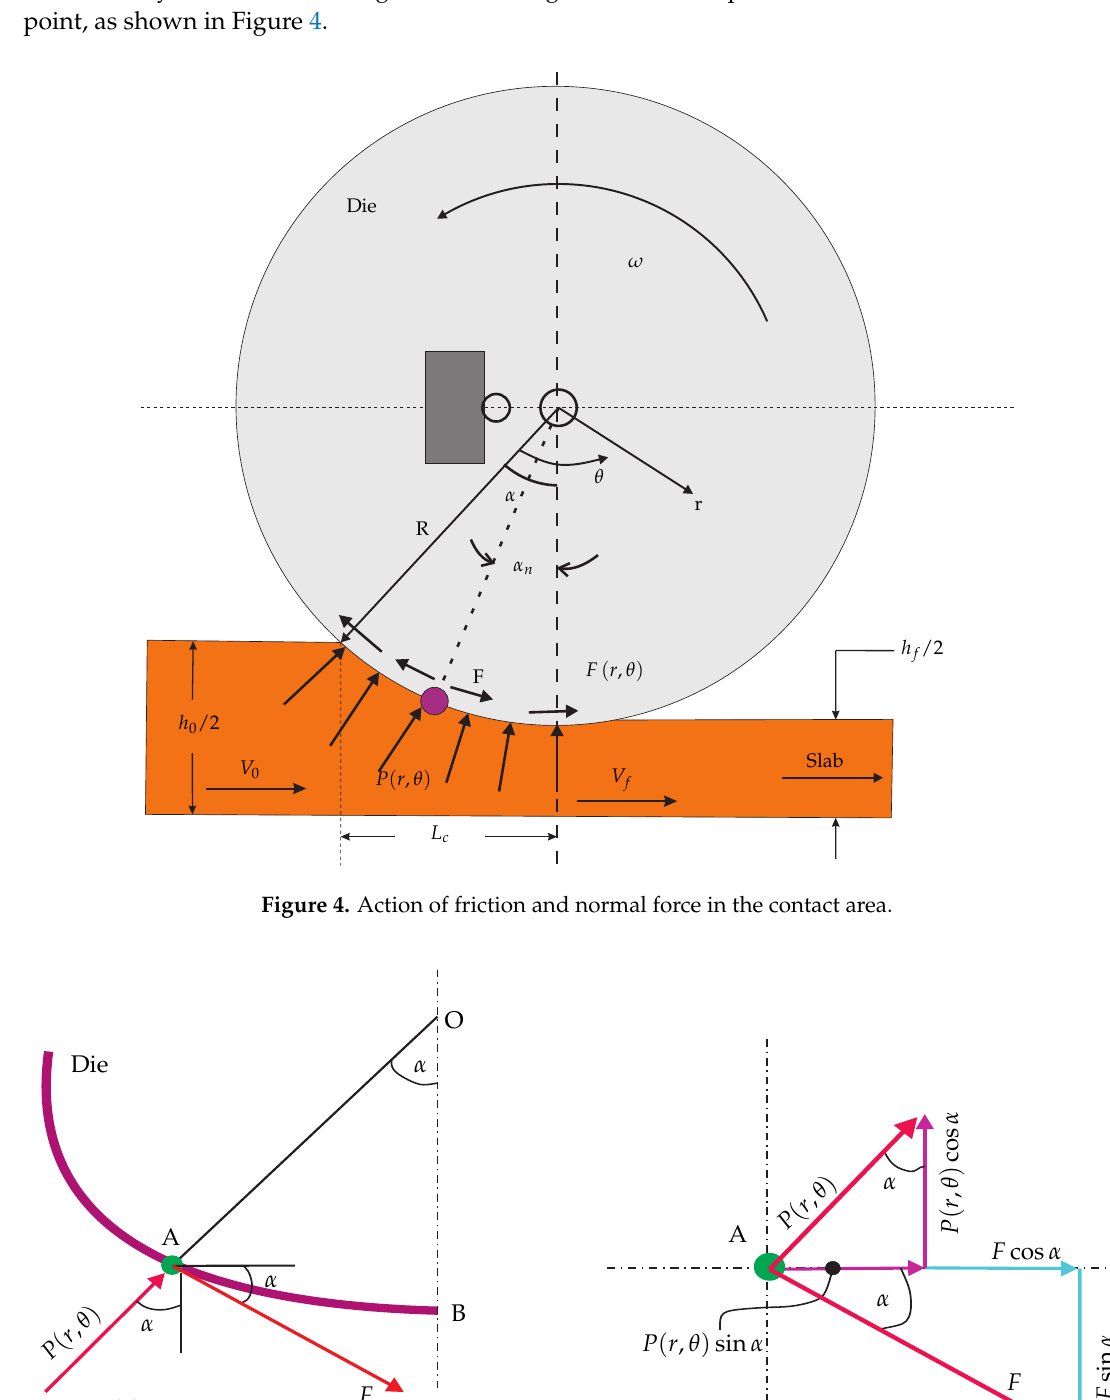
Figure 5. Component force. (a) Direction of the two forces, (b) Resolved force that act on rolling die